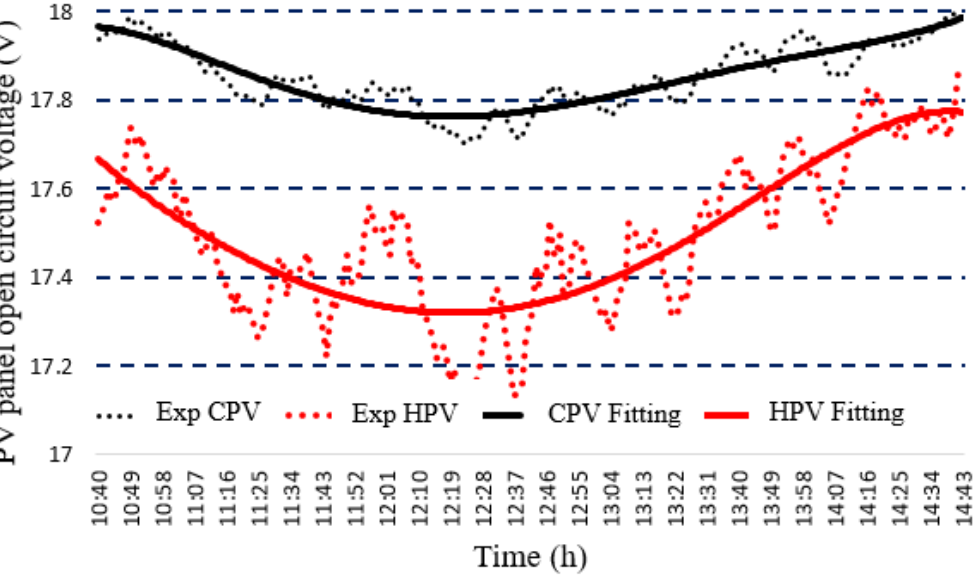
Figure 6. Difference in panels’ open-circuit voltages.